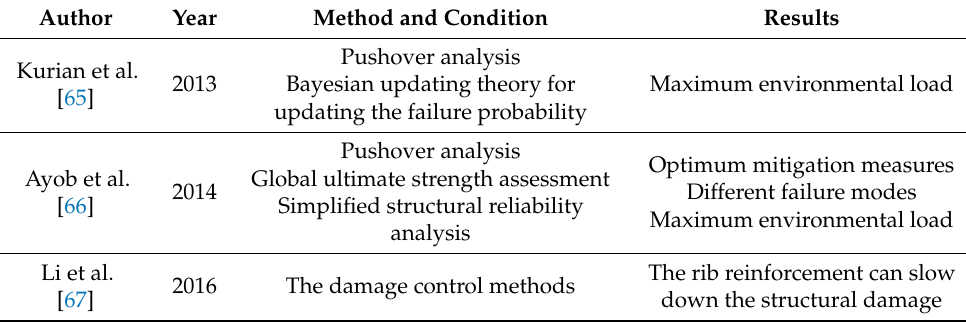
Table 3. Various methods of failure assessment used in marine